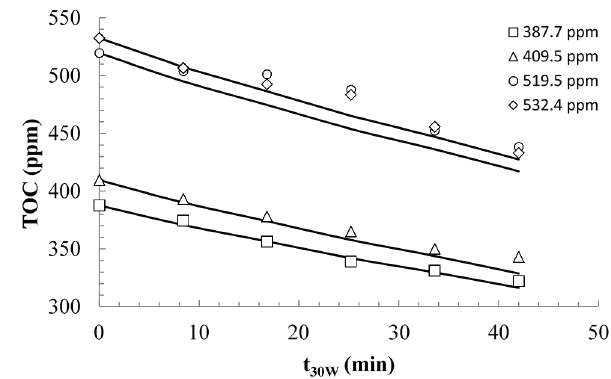
Figure 9. Validation of the TOC photocatalytic degradation with 0.4 g/L of catalyst load.